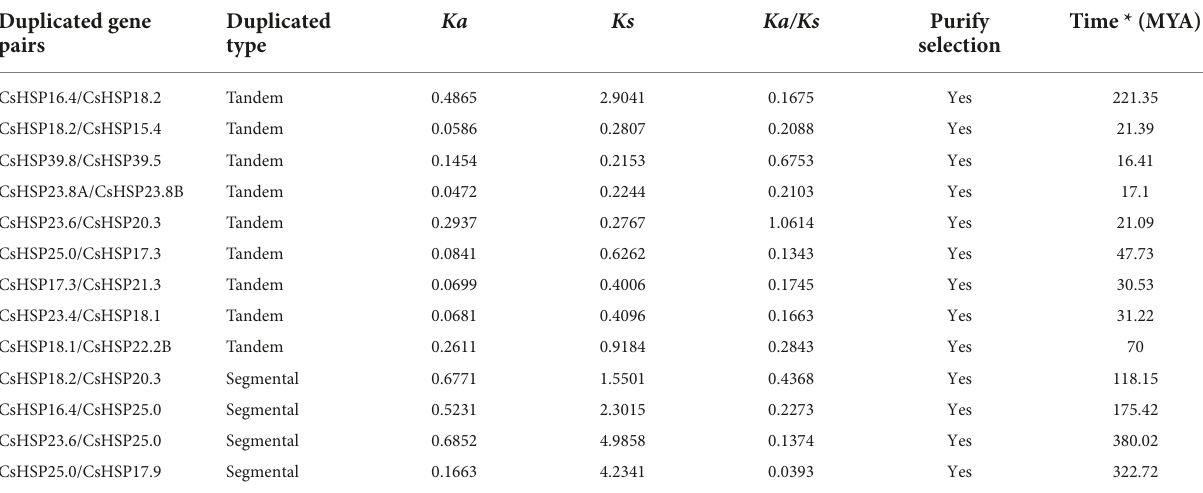
TABLE 2 Ka/Ks calculation and divergent time of the duplicated cucumber HSP20 gene